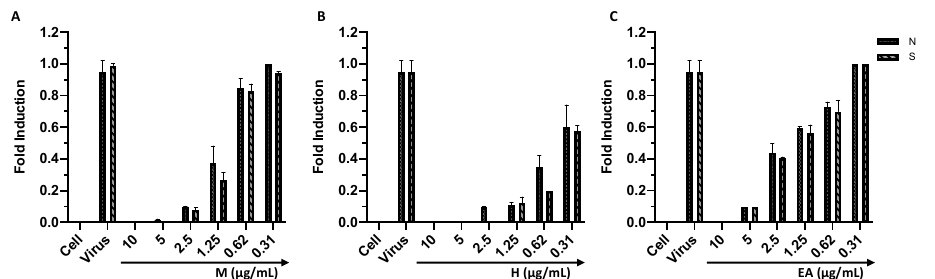
Figure 6. Analysis of HCoV-229E S and N expression levels after treatment with M ( A ), H ( B ), and EA ( C ). Data represent the mean ± standard deviation (SD) of three independent experiments.